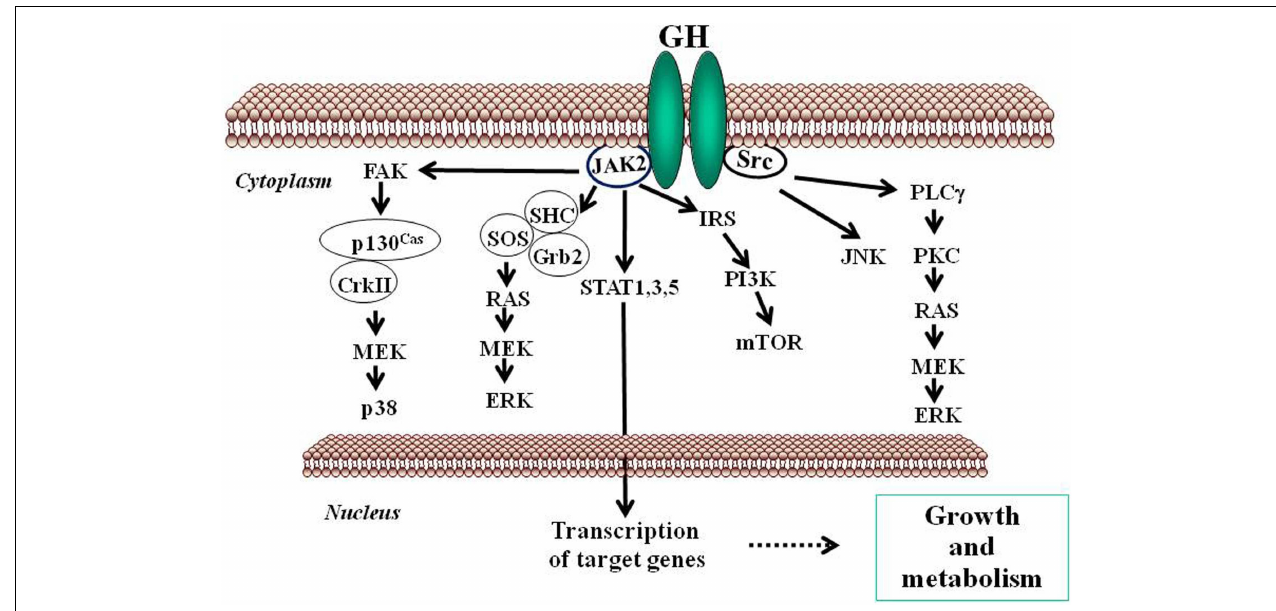
by JAK2 via the adaptors SHC, GRB, and SOS. JNK is activated by SRC.The PtdIns 3-kinase and the serine-threonine-protein kinase mTOR pathway is activated by JAK2 via IRS phosphorylation.These signaling pathways influence, directly or indirectly, transcription of genes involved in growth and metabolism. ERK, extracellular signal-regulated kinase; FAK, focal adhesion kinase; Grb, growth factor receptor-bound protein; IRS, insulin receptor substrate; JAK2, Janus kinase 2; JNK, c-Jun N-terminal kinase; MEK, dual